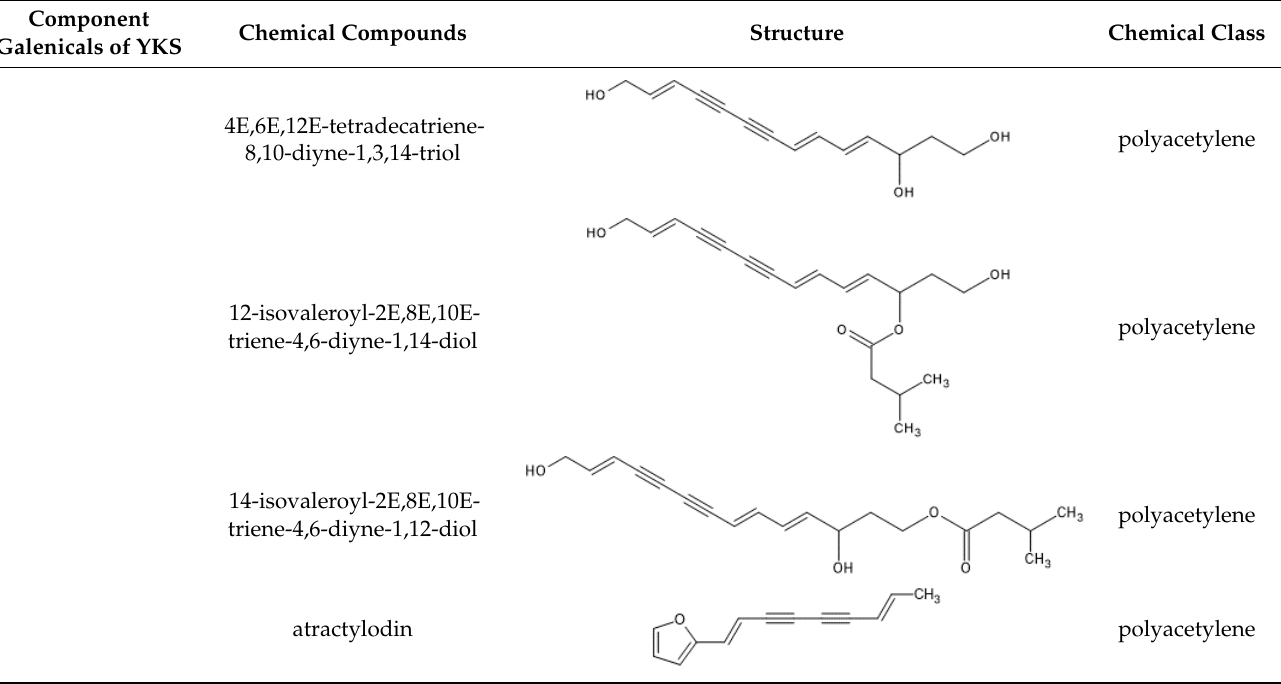
Table A1. Chemical compounds identified in the three-dimensional high-performance liquid chro- matography profile chart of Yokukansan (YKS).